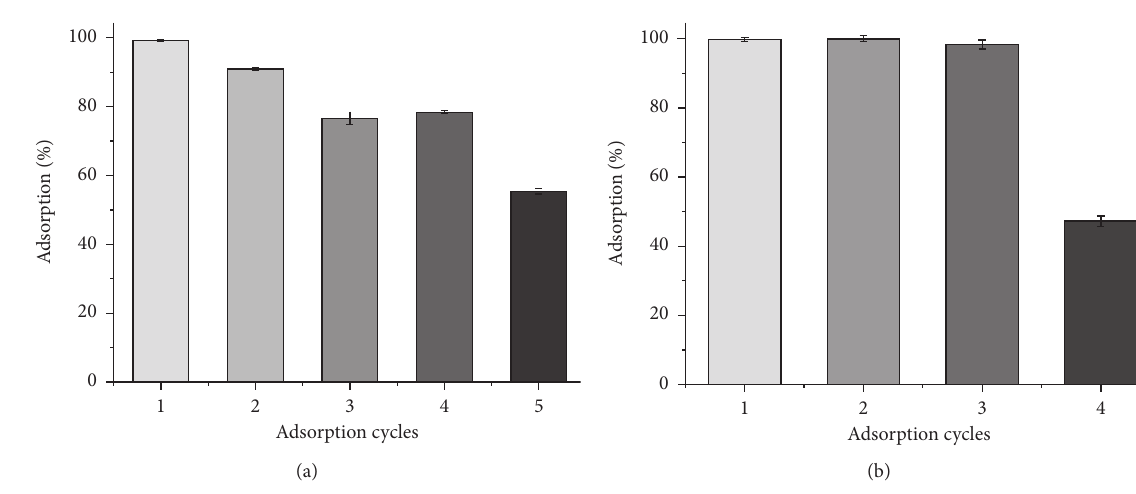
Figure 11: Cr(VI) adsorption cycle of (a) TR (b) PSS.